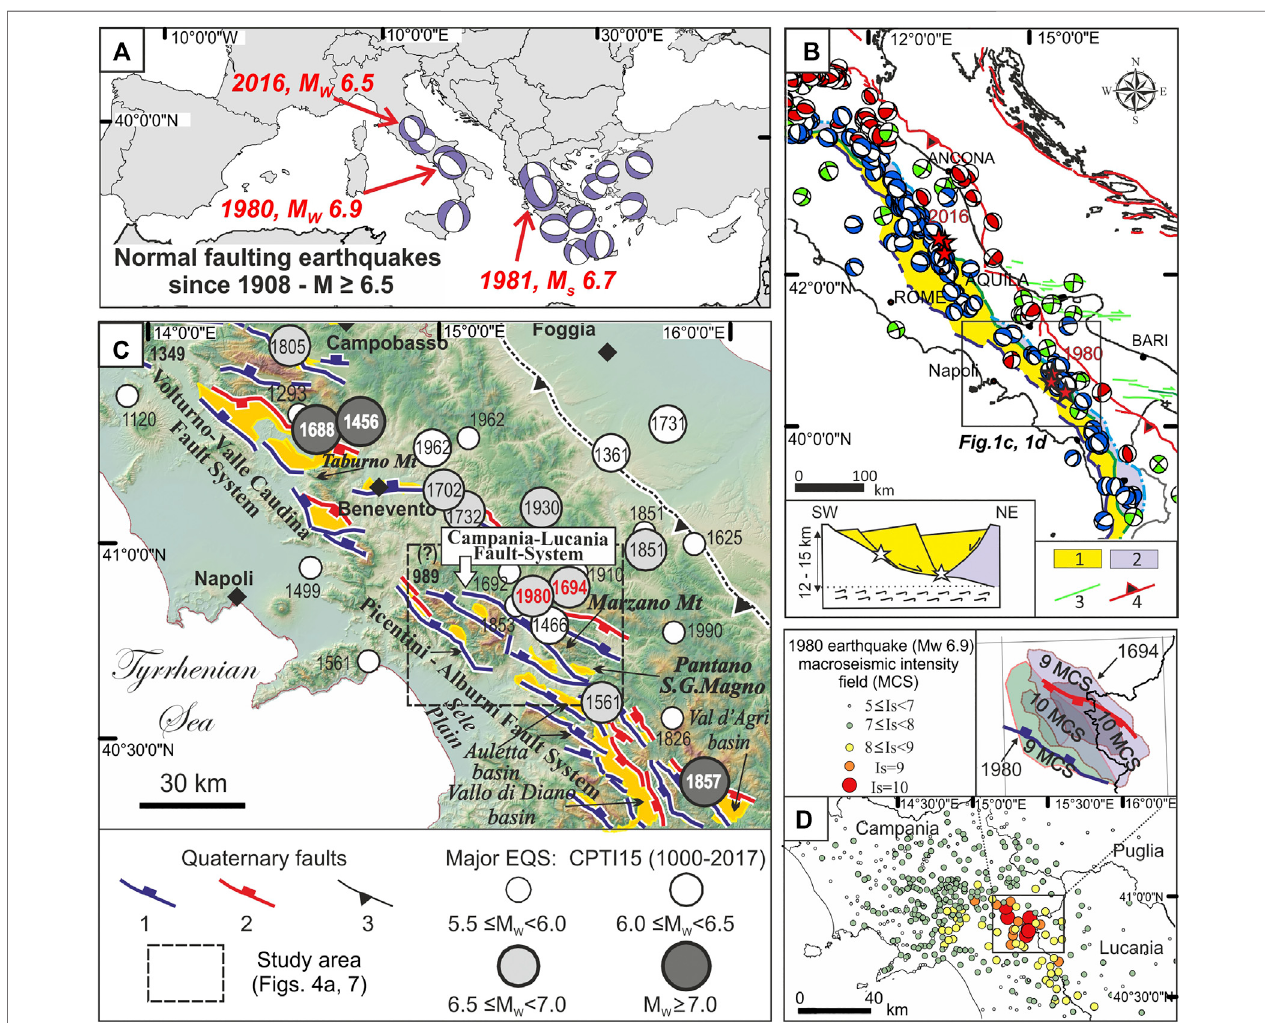
FIGURE 1 | The Campania-Lucania 1980 earthquake in the Mediterranean seismotectonic context. (A) Mediterranean normal faulting earthquakes with M ≥ 6.5 since 1908 derived from the World Stress Map database (Heidbach et al., 2018). (B) The Italian earthquake focal mechanisms (M W ≥ 4.0) from 1908 to 2015 (Montone and Mariucci, 2016); red stars represent the mainshocks of 2016/2017 Central Italy and 1980 Campania-Lucania seismic sequences. The background colors indicate the extensional seismotectonicprovincesasin Lavecchia et al.,2021:Key:1 (cid:1) Extensional seismogenic province;2 (cid:1) Deepextensionalseismogenic province;3 (cid:1) right-lateralstrike-slipfaultswithintheAdriaticforeland;4 (cid:1) Activeouterthrustsystem;Thesketchinthelowerleftcornerrepresentsthesimpli fi edmodeloftheApennine extensional system as in Lavecchia et al., 2011. (C) Active faults in Southern Italy (after Adinol fi et al., 2015) with major historical and instrumental earthquakes from ParametricCatalogueofItalianEarthquakes,CPTI15v2.0(Rovidaetal.,2019).Key:1,east-dippingnormalfaults;2,west-dippingnormalfaults;3thrustfaults. (D) 1980 earthquake macroseismic fi eld from the Italian Macroseismic database DBMI15 v2.0 (Locati et al., 2019). The inset in the right upper corner represents the contour of IX and X MCS intensity of the 1694 and 1980 earthquakes.